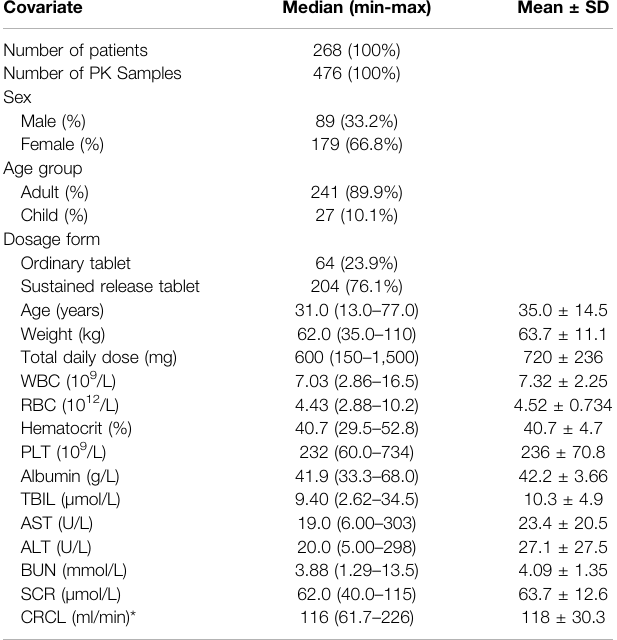
TABLE 1 | Demographic and characteristics of patients.